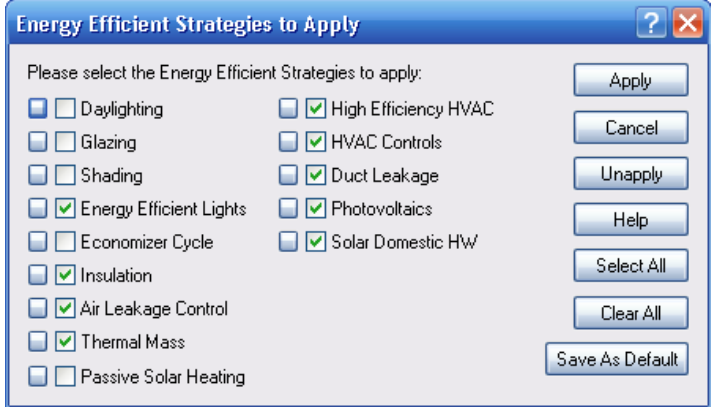
Figure 3. Energy efficient strategies dialog box.